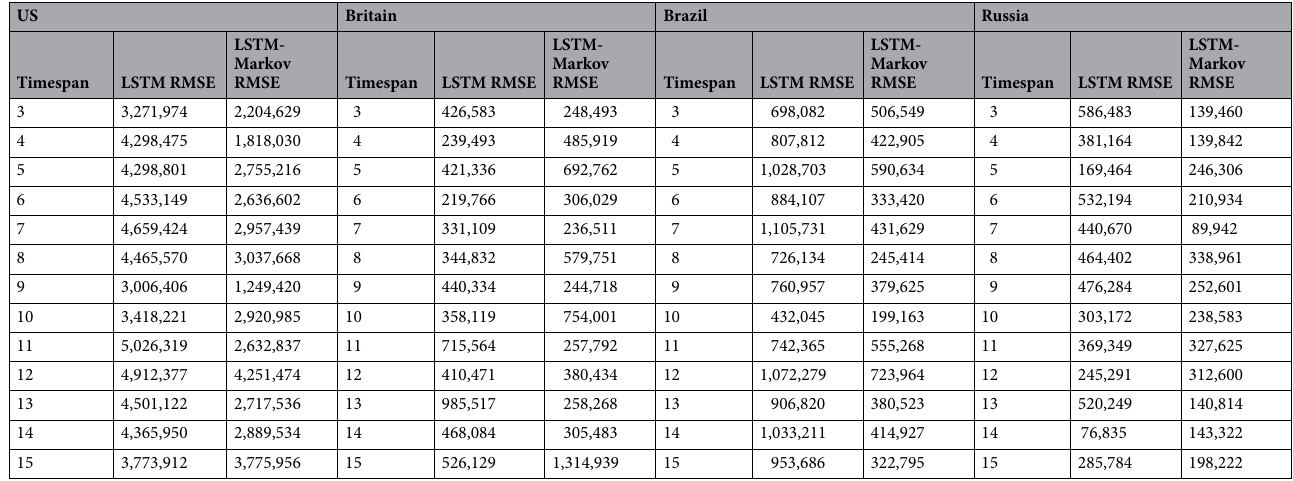
Table 1. The model’s RMSE of different time